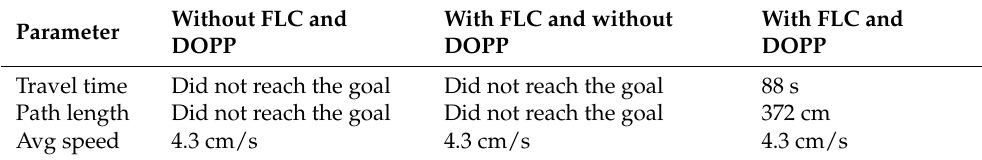
Table 3. Summarised test results of Experiment